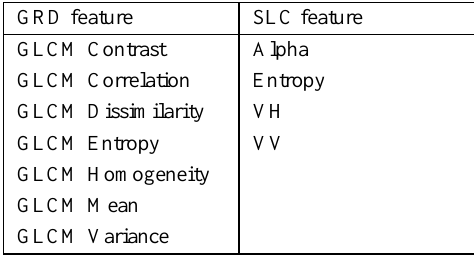
Table 1 . Sentinel-1 GRD- and SLC-derived features